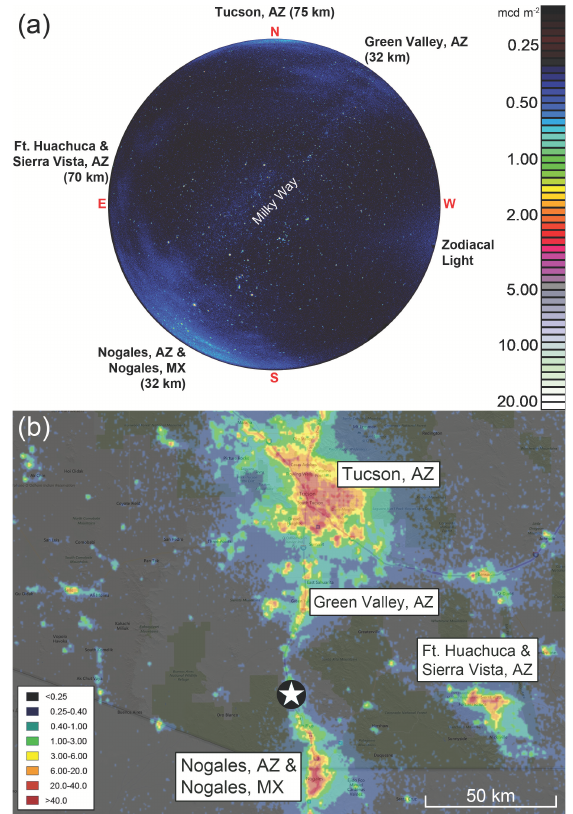
Figure 3. ( a ) An all-sky image of the night sky from Tumacácori National Historical Park in Arizona, U.S., obtained on the night of 5 February 2018. The view is centered on the zenith, and the cardinal points on the horizon are indicated in red letters. The image orientation follows the astronomical convention for all-sky imagery (north at top and east left). The color bar gives sky luminances in units of mcd m − 2 . Sources of natural and artificial light are labeled; anthropogenic sources and their radial distances from the site are listed. ( b ) VIIRS-DNB annual cloud-free composite upward radiance data (false colors) for southeast Arizona, U.S., in 2017 overlaid on a Google Map base. Radiances are given in units of nW cm − 2 sr − 1 according to the color key at the lower left, and a 50-kilometer scale bar is shown at the lower right. North is up, and east is right, according to the usual cartographic convention. The location of Tumacácori National Historical Park is indicated by the five-pointed star at the bottom-center. Other locations referenced in (a) are labeled. Background map copyright 2019 Google, INEGI, used with